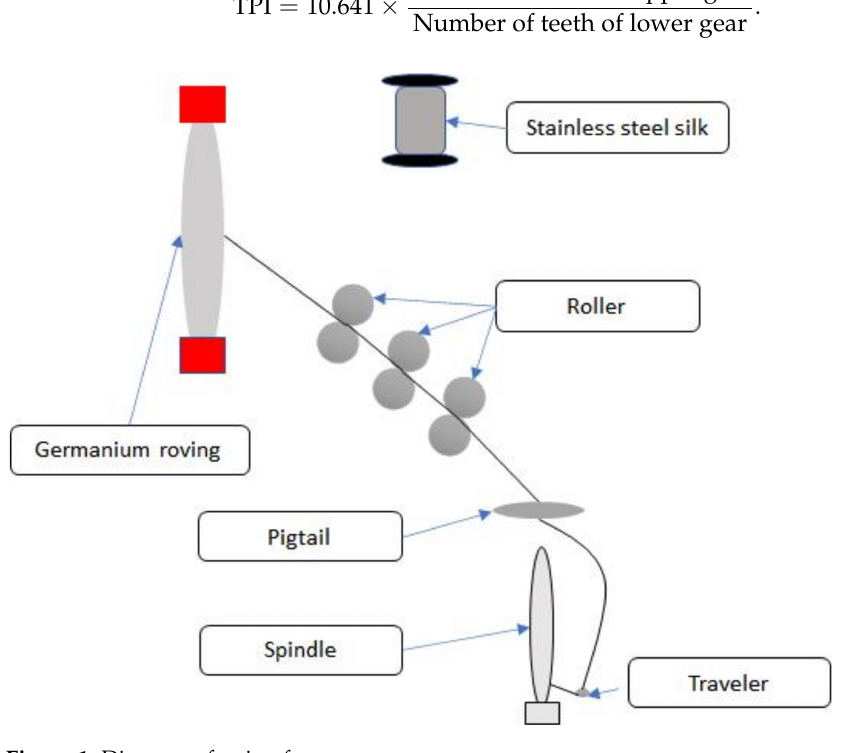
Figure 1. Diagram of a ring frame.